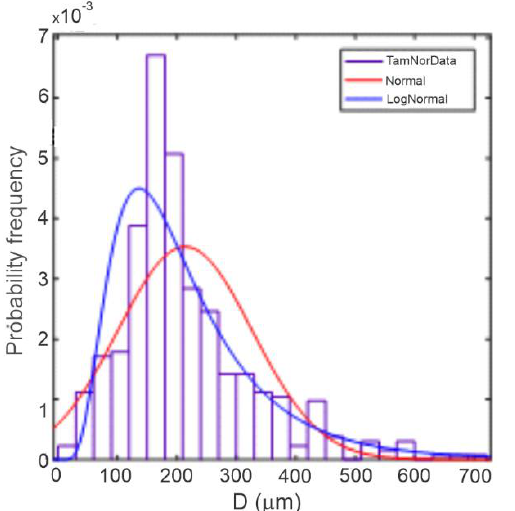
Figure 6. Flocs fractal dimension obtained after 45 min in RAF for the Usumacinta River sediment.